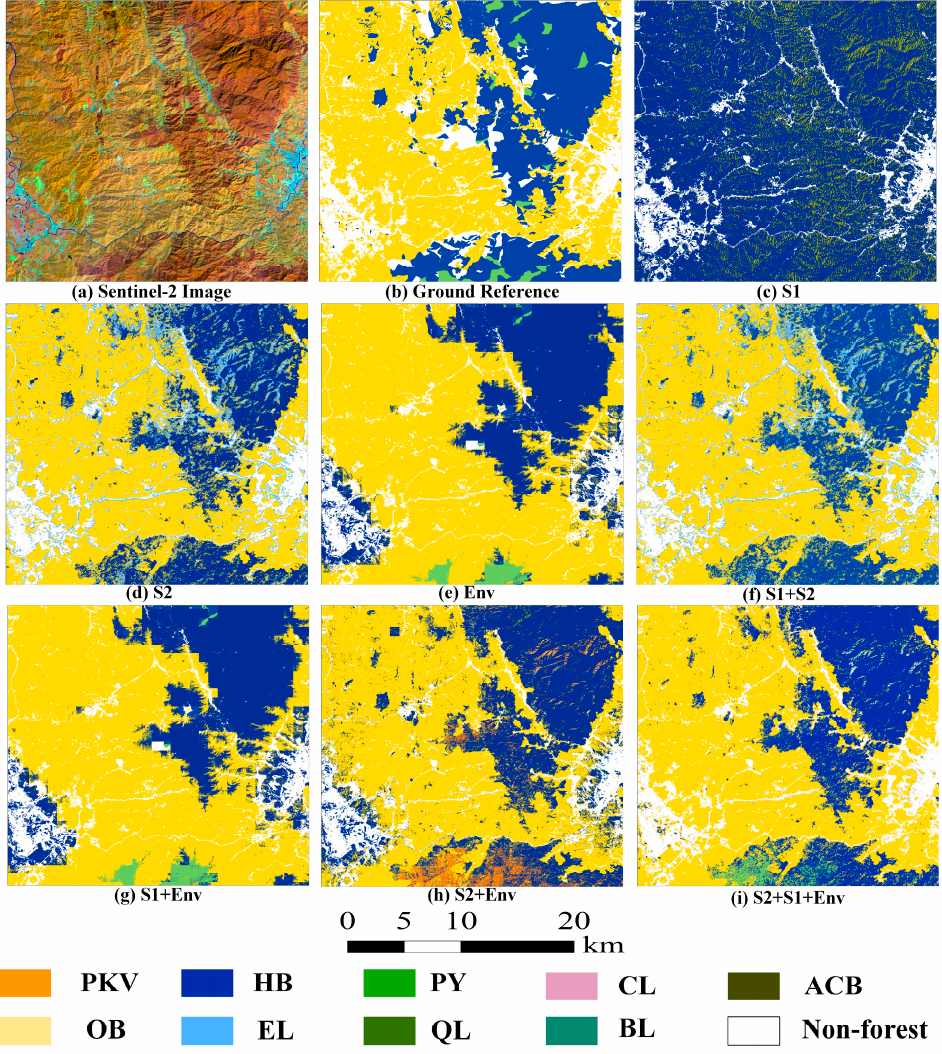
Figure 6. Detailed view of the tree-species maps with better interpretation derived under different cases. ( a ) false-color image synthesized from the SWIR1, NIR, and blue bands; ( b ) ground survey labels; and ( c – i ) RF maps predicted based on the 7 feature sets.